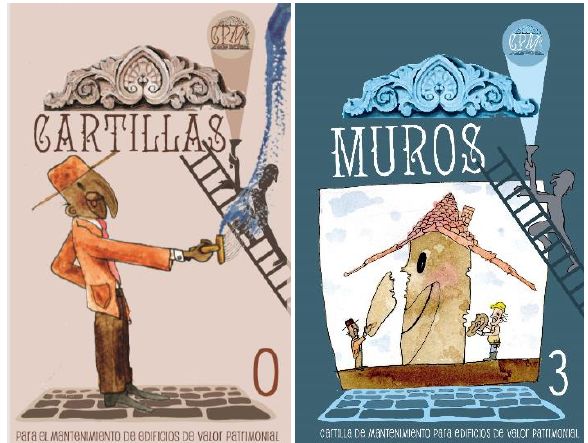
Figure 5. The covers of the maintenance booklets.